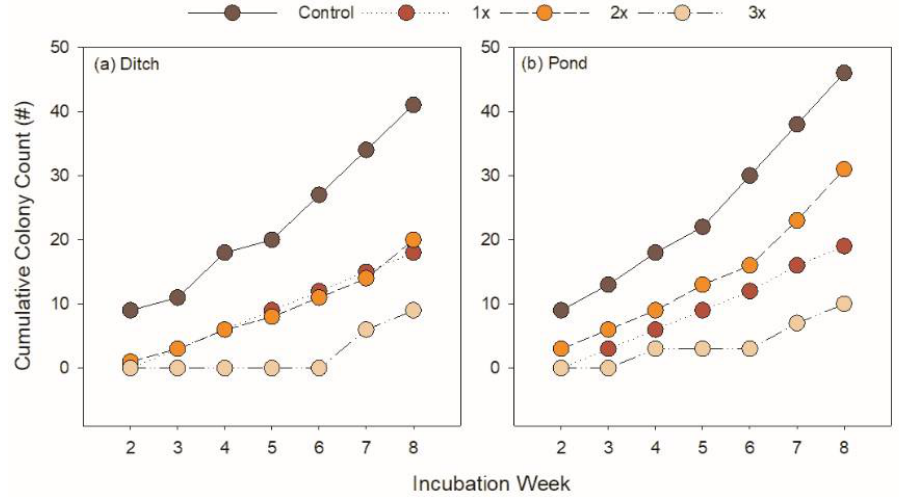
Figure 1. Sum of microbial colony development over the course of the incubation.